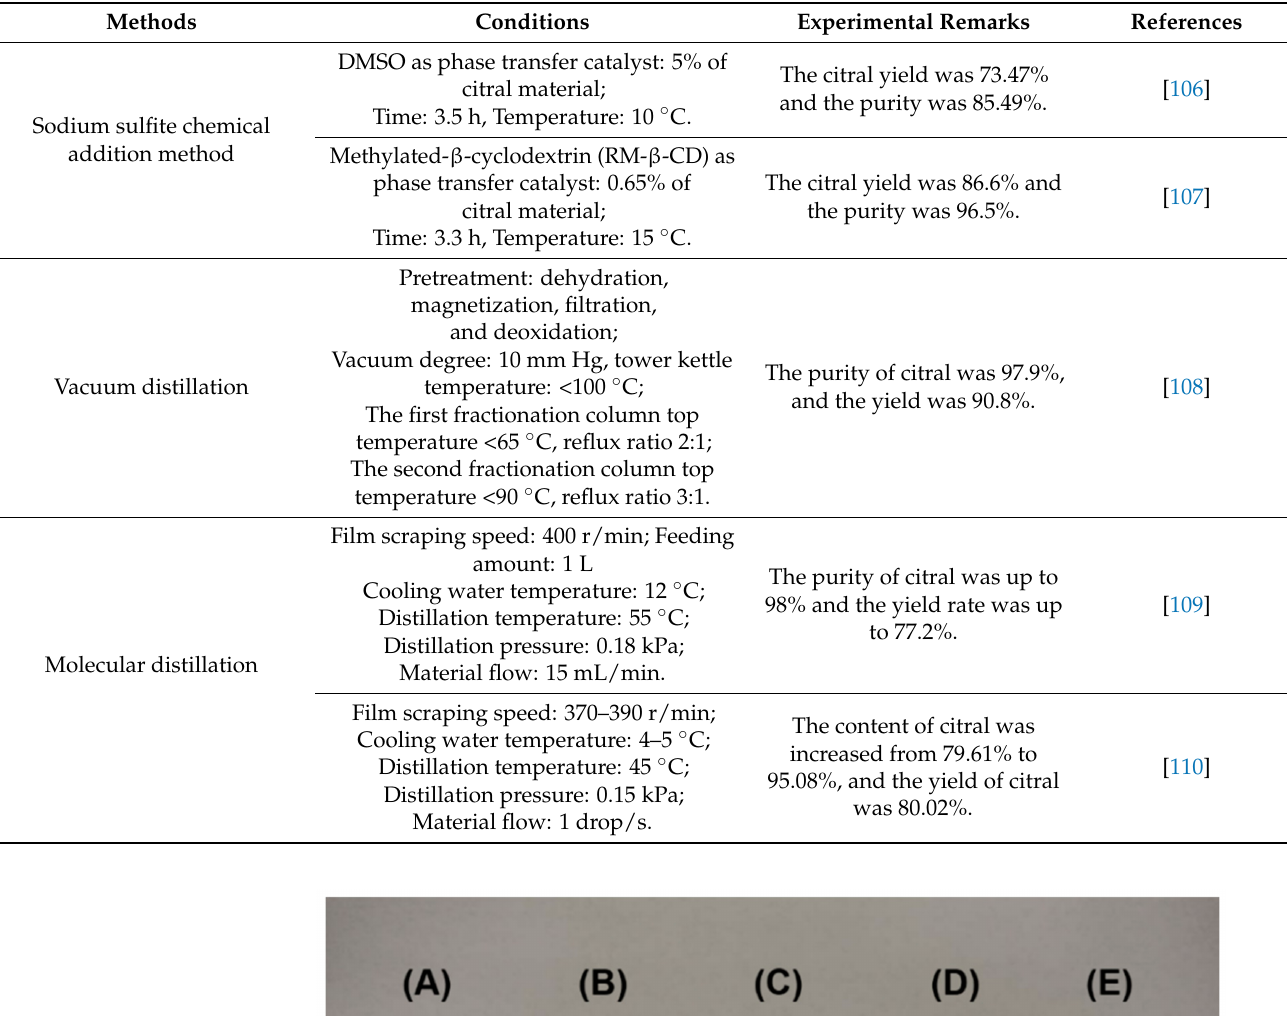
Table 5. Purification technologies of citral.